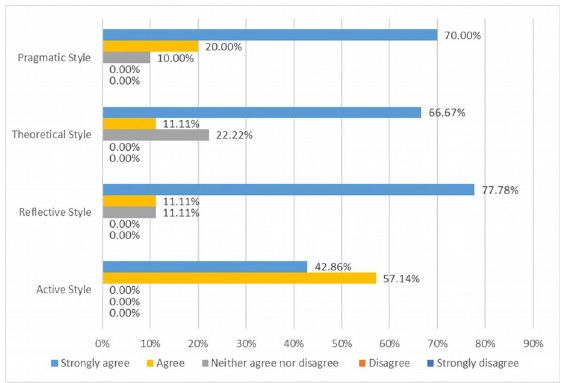
Figure 7. I can learn at my own